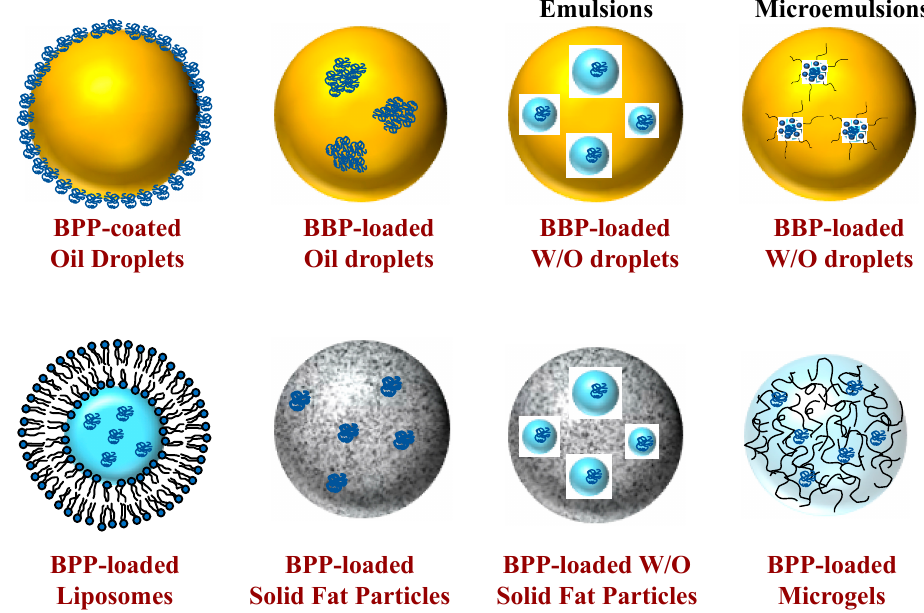
Figure 1. Schematic diagrams of colloidal delivery systems that could potentially be used to encapsulate, protect, and delivery hydrophilic bioactive proteins and peptides. All these systems could be dispersed in aqueous-based products.